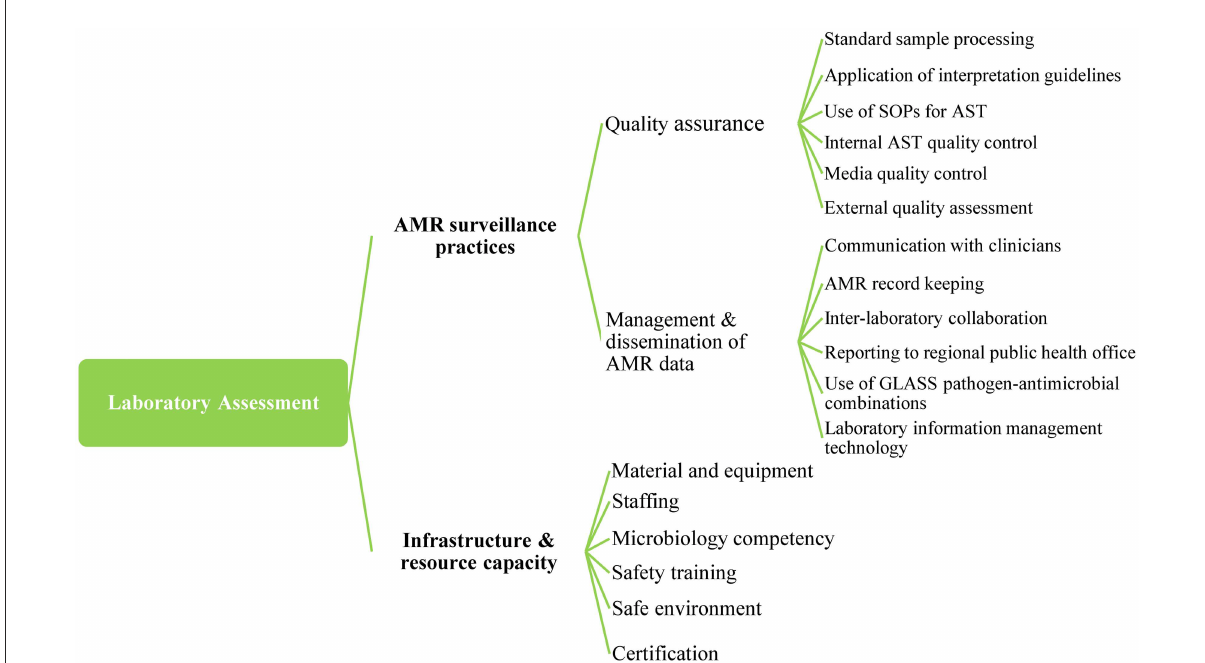
FIGURE1 Dimensions, subdimensions, and indicators of tool developed for the assessment of health facilities in Kenya 2020. AMR, Antimicrobial Resistance; AST, Antimicrobial Susceptibility Testing; GLASS, Global Antimicrobial Resistance and Use Surveillance System; SOPs, Standard operating